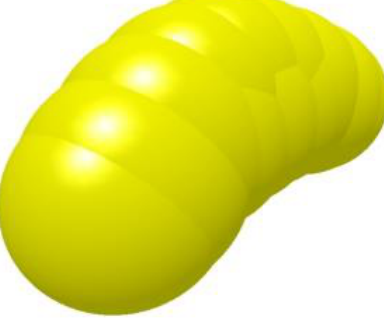
Figure 5. Alfalfa seed model. Table 1. Parameters of discrete element model for alfalfa seeds.